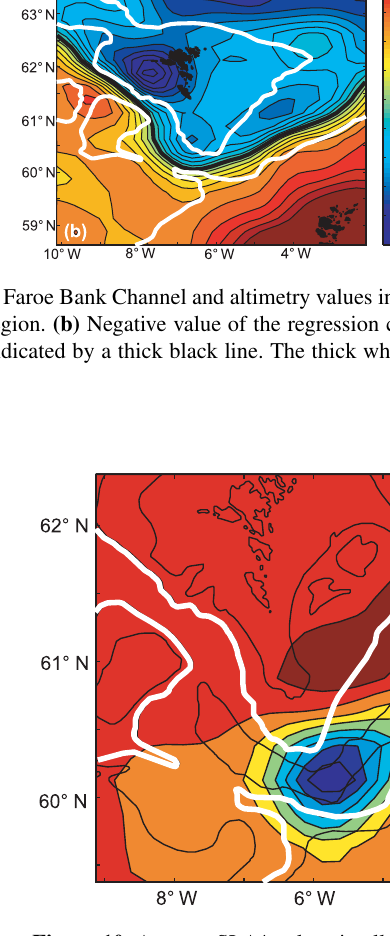
Figure 10. Average SLA* values in all grid points of the region in periods when the reproduced (Eq. 1) velocity at 200m depth at ZA is westwards. The average velocity direction measured by ADCP at 200m depth at site SC is shown by a black arrow (copied from Fig.